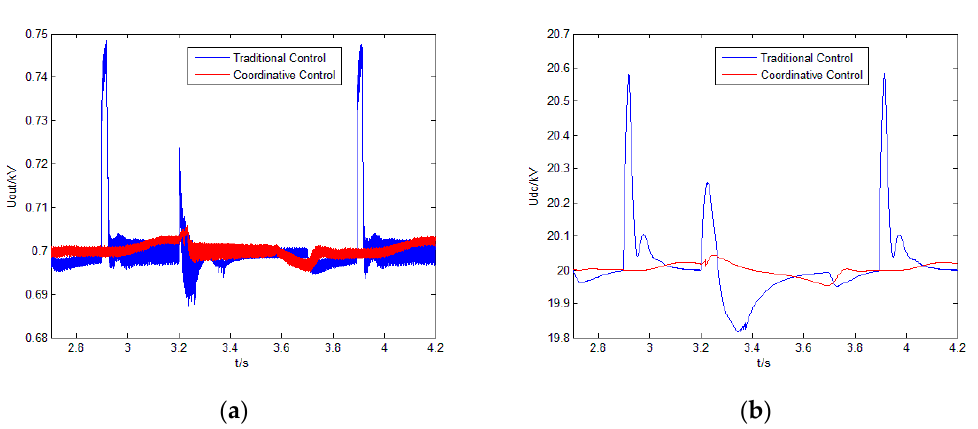
Figure 13. The comparison of voltage response under continuous power fluctuation: ( a ) the LVDC bus voltage response; ( b ) the HVDC bus voltage response.